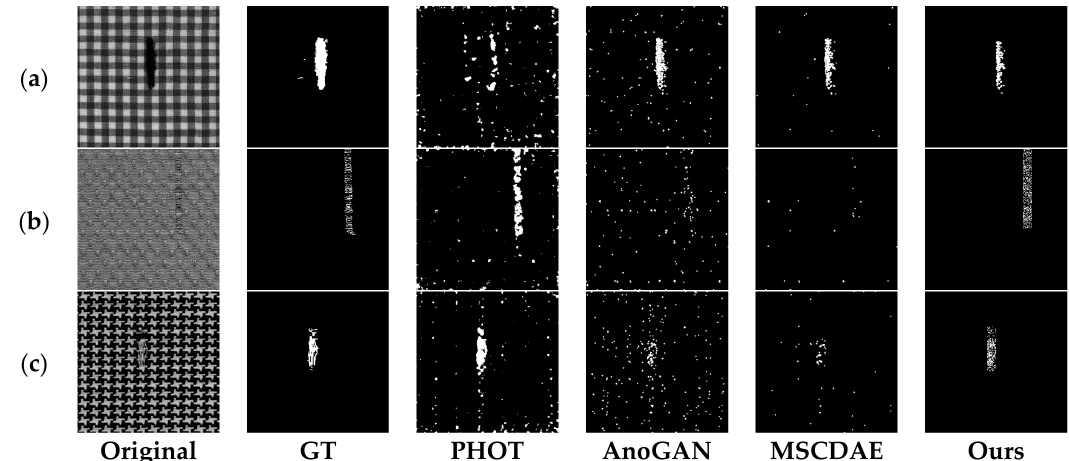
Figure 8. Segmentation results of defective samples with three kinds of textural background from Patterned Fabric dataset